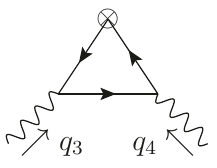
Figure 4 . The diagrams needed for the lowest order in α s matrix elements of the quark operators. The diagrams are with the q legs interchanged must also be taken into account. The crossed 3 , q 4 circle indicates the insertion of one of the quark